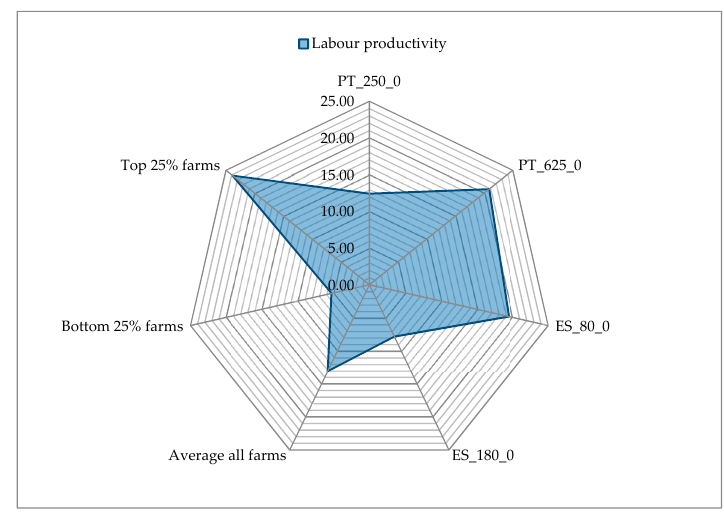
Figure 16. Productivity of Labor (kg LW / h). Source: model results.